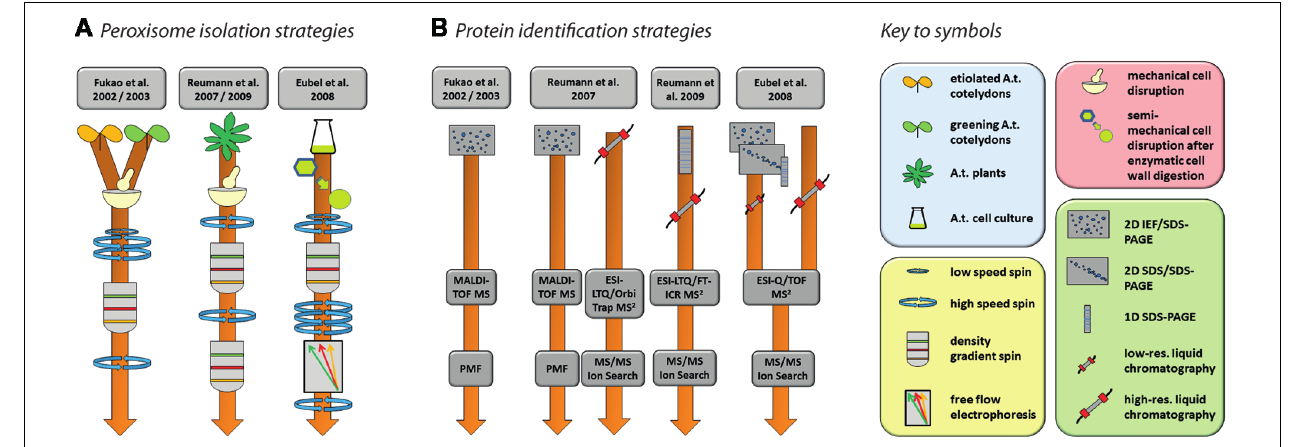
FIGURE 2 | Strategies for the purification of Arabidopsis peroxisomes (A) and the identification of proteins (B) as performed by Fukao etal. (2002, 2003), Reumann etal. (2007, 2009), and Eubel etal. (2008). Please refer to the original publication for more detailed information on materials and methods.